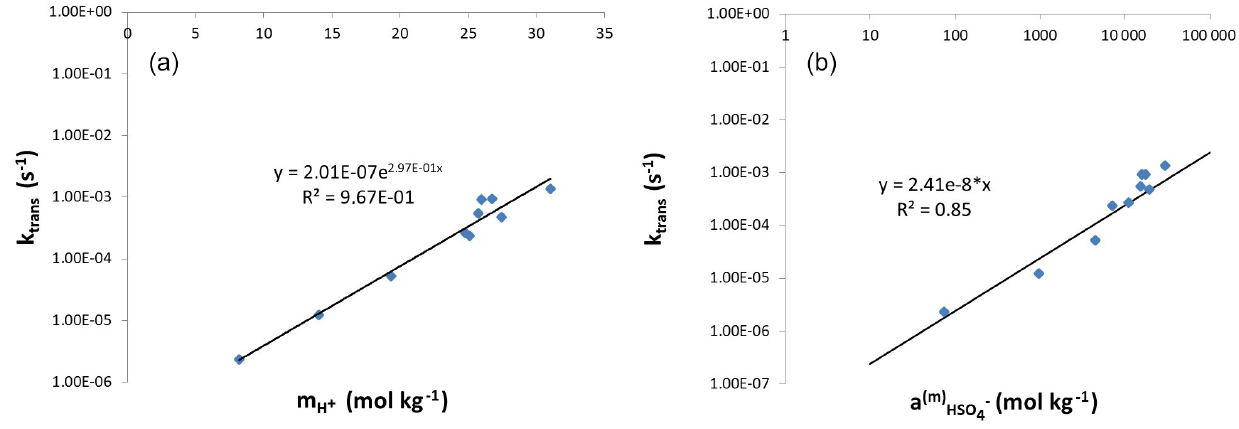
Figure 2. Kinetic rate of transformation of pinonaldehyde as a function of m H + , the molality of ion H + (a) , and a (m) (b) on a molality basis. HSO − 4